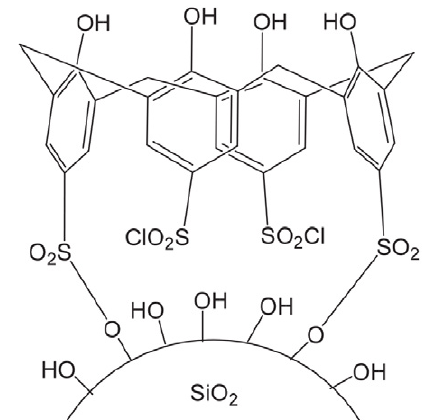
Figure 3. Loss factor (tan δ) versus temperature curves of rubber samples containing various processing aid agent.